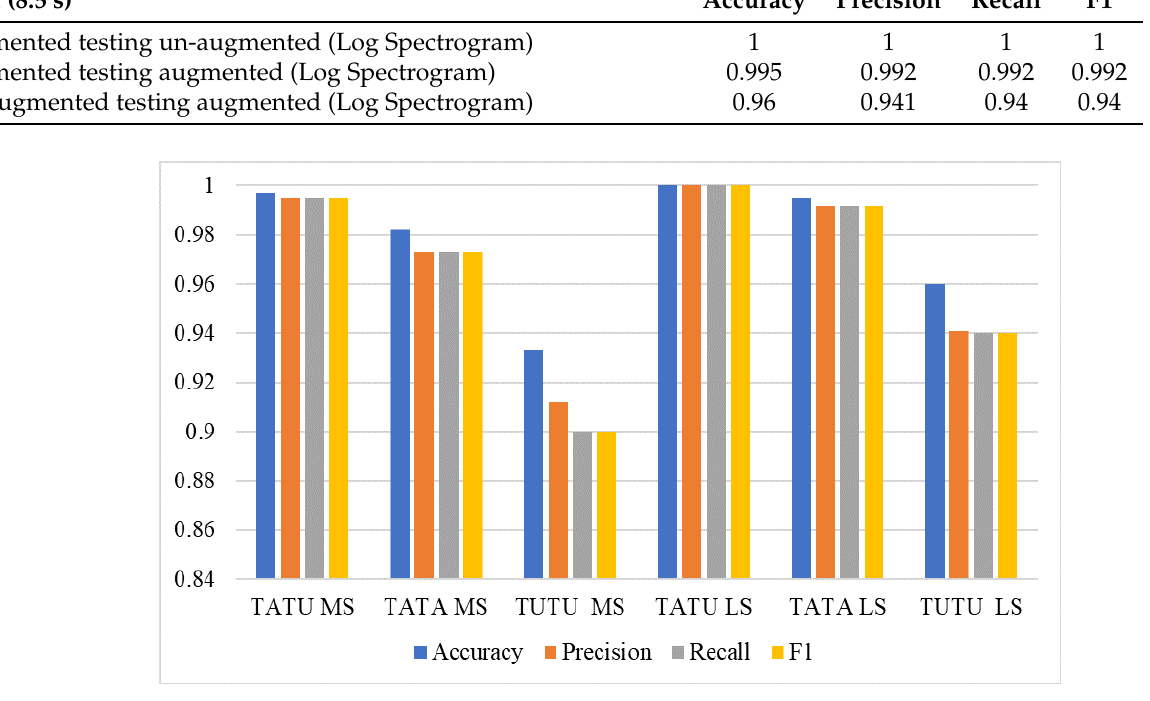
Figure 9. LSTM comparison using log spectrogram and Mel